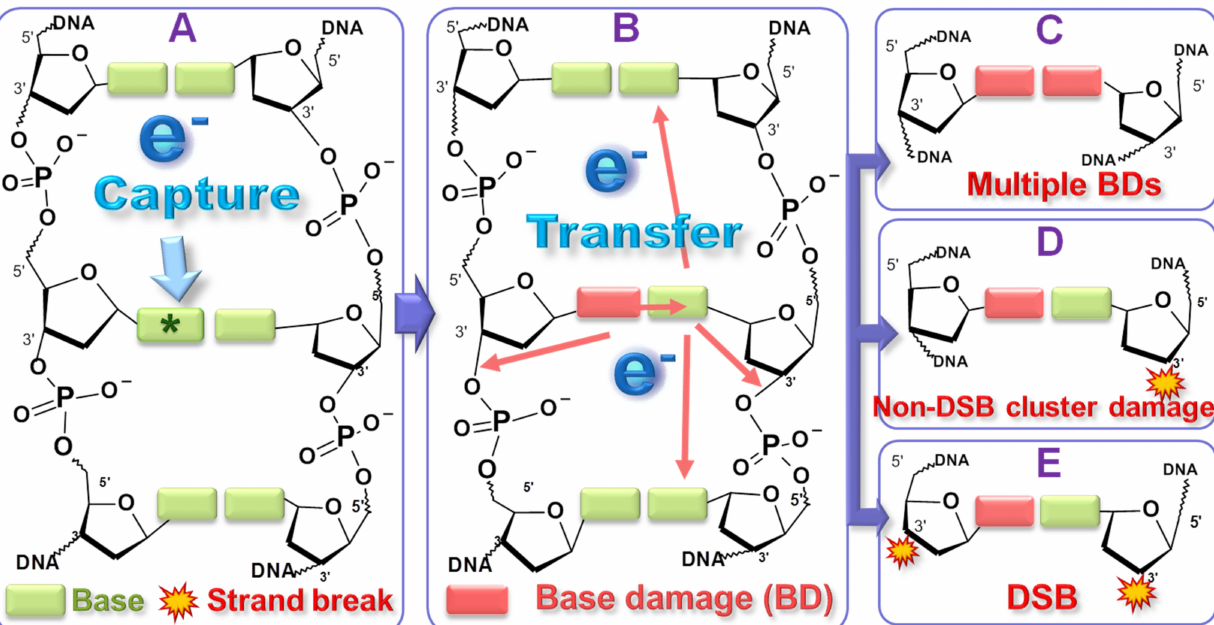
Figure 6. Diagram of the reaction pathways for a single LEE to produce all observed types of DNA damage. Possible electron transfer sites are indicated by red arrows. The electron (e − ) is initially captured by a base, forming a core-excited transient anion ( A ), where DEA can occur producing a base damage (BD). Alternatively, the electron can transfer to the phosphate group to produce a SSB. The captured electron can also detach from the base anion, leaving the base in a dissociative state ( B ). The base is damaged and the detached electron transfers to other sites where DEA occurs (B). Transfer to the opposite base can result in two adjacent BDs ( C ), whereas transfer to the phosphate unit in the same or opposite strand, can cause a strand break via C-O bond breakage (SSB via DEA + BD) ( D ). A DSB can be produced, if the BD on the left strand is converted to a strand break ( E ). Electron hopping between bases can create a BD or SSB farther away from the initial electron capture site [118]. (Copyright 2021 American Chemical